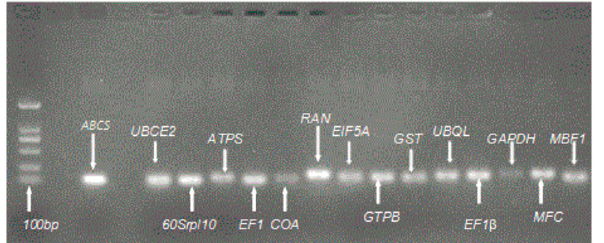
Fig 2. The results of agarose gel (1.0%) electrophoresis of RGs. The amplification of a single product of the expected size for each gene tested in this study is